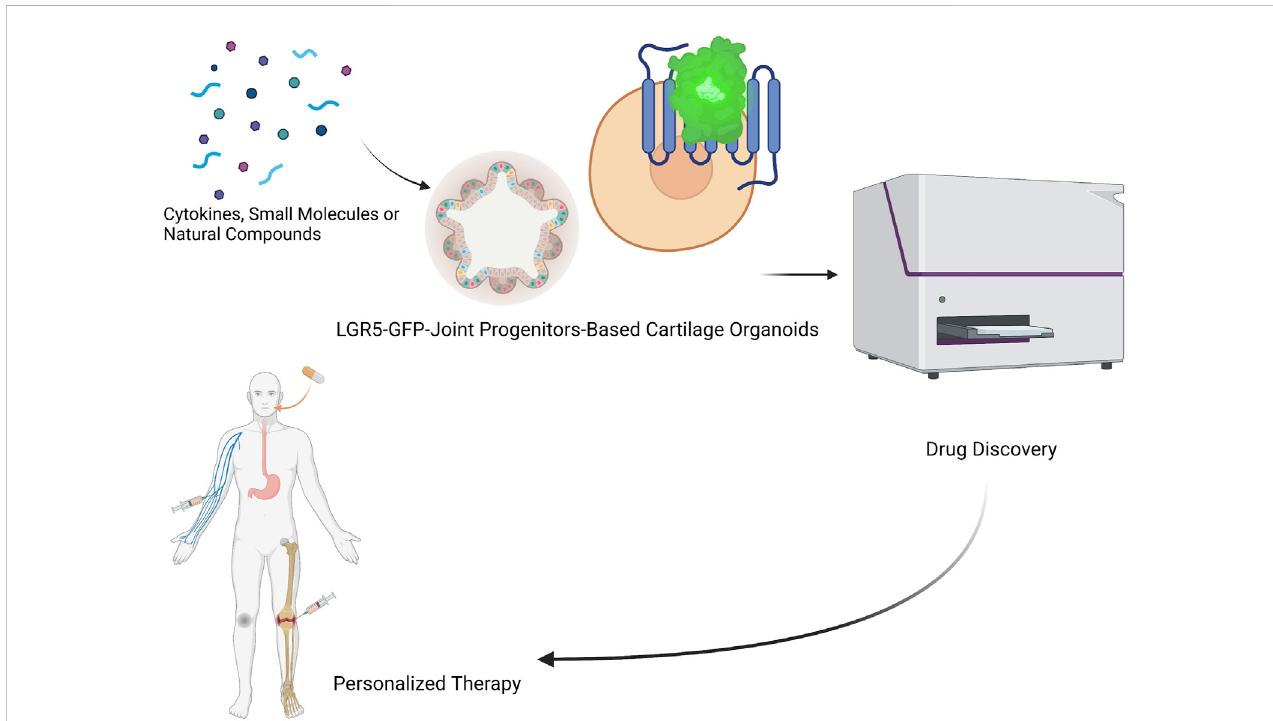
FIGURE 5 LGR5-joint progenitors-based cartilage organoids for realization of novel drug discovery (identi fi cation of novel cytokines, small molecules, and natural compounds), and personalized regenerative therapy of cartilage